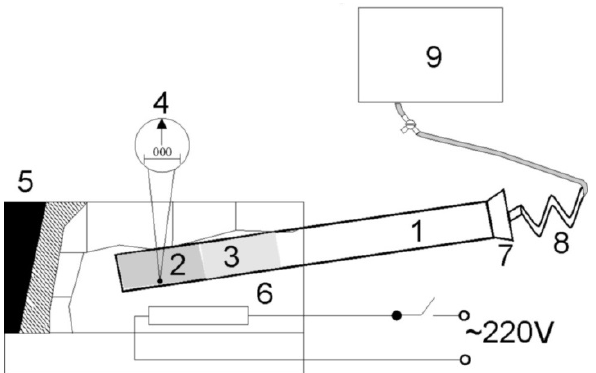
Figure 1. Installation scheme for thermal decomposition of electrodes: (1) heat chamber, (2) cartridge, (3) porous ceramic plug, (4) thermocouple, (5) muffle furnace, (6) heater, (7) rubber plug with a tube for gas extraction, (8) standard coil, and (9) measuring container for released gas.